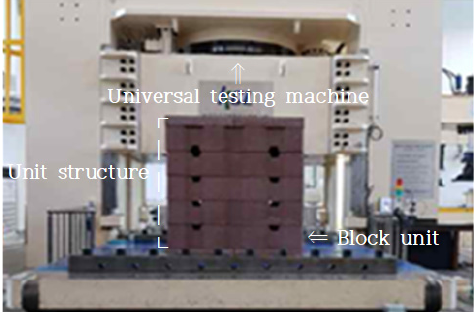
Figure 10. Maximum compressive load test of the unit structure (Seismic isolation device test machine (JKS, Korea)).